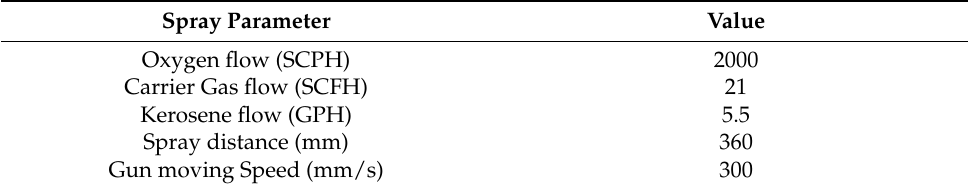
Table 3. Parameters of HVOF